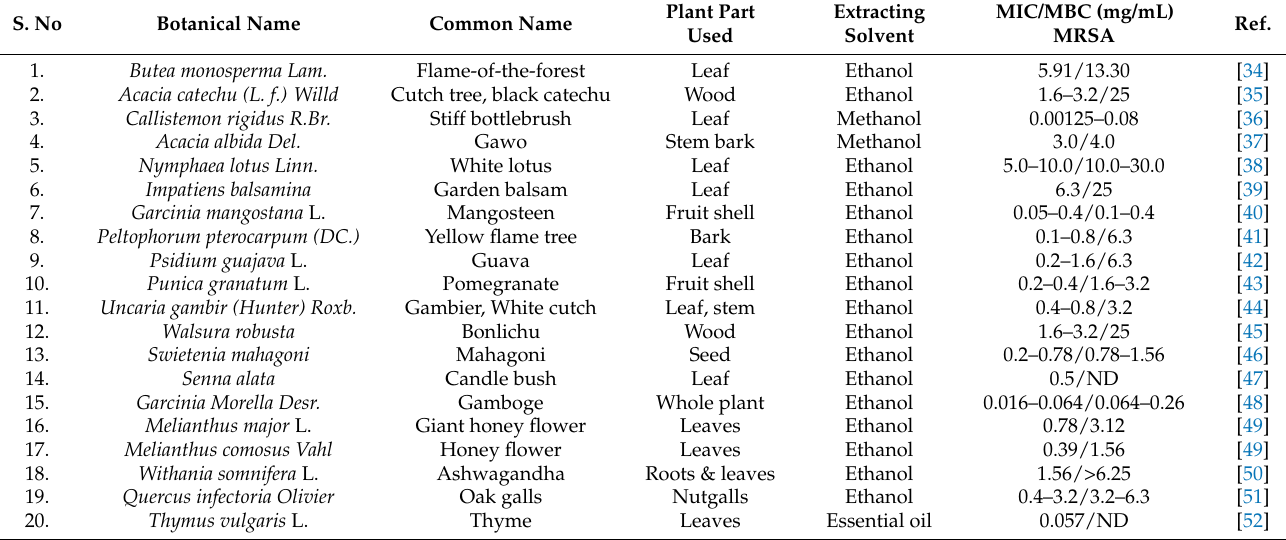
Table 1. Anti-MRSA activities of medicinal